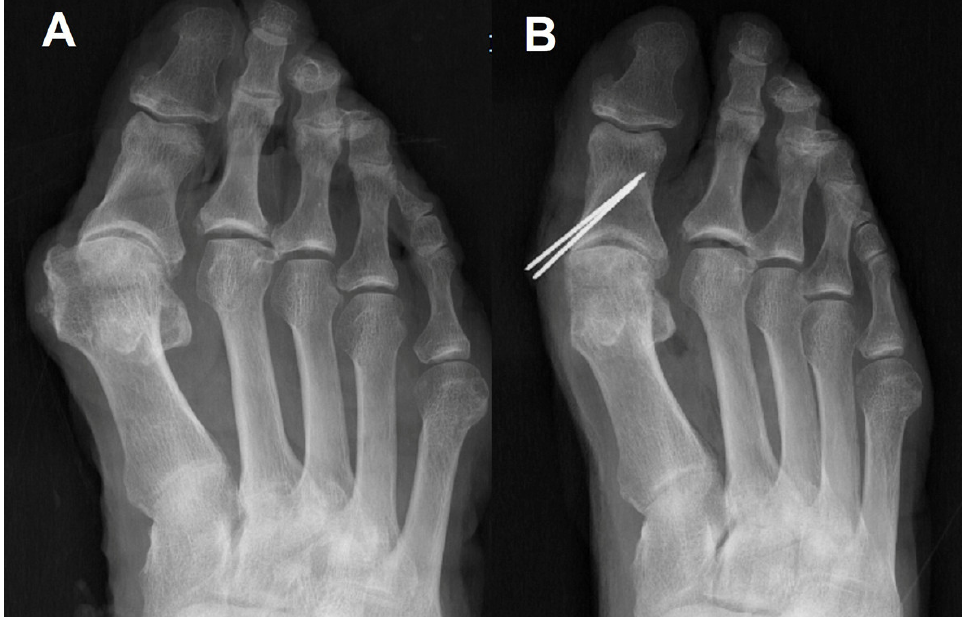
Figure 3. Proximal phalanx osteotomy alone reduces sesamoids to some degree but not perfectly. ( A ) Preoperative simple radiograph of hallux valgus in cadaver; ( B ) Modified proximal phalanx osteotomy was performed. Bunionectomy was done for making K-wire entry point. Table 1. Hallux valgus angles (HVA) and 1st−2nd intermetatarsal angles (IMA) before/after the Akin osteotomy and proximal metatarsal osteotomy, except for specimen 2 (unit: degrees). Specimen